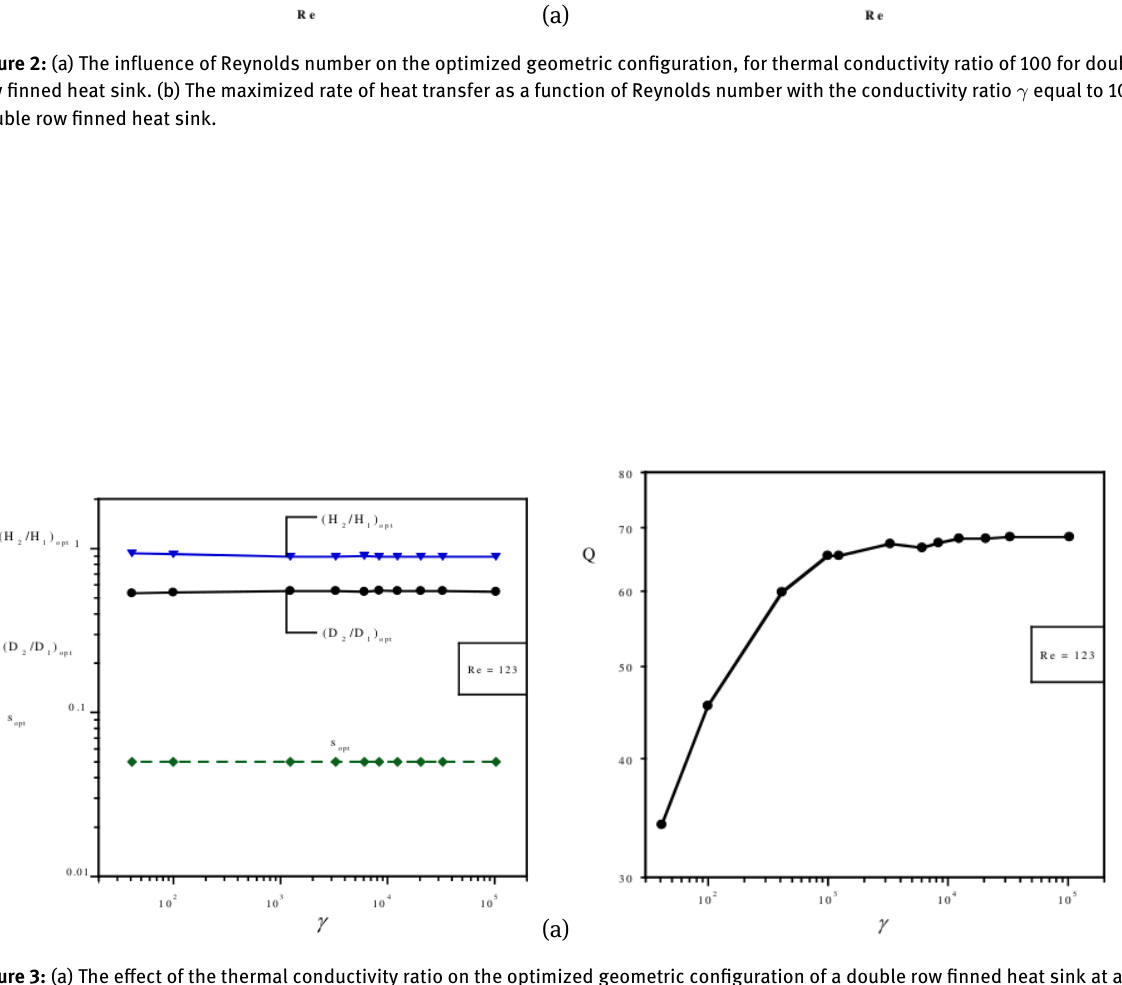
Figure 3: (a) The effect of the thermal conductivity ratio on the optimized geometric configuration of a double row finned heat sink at a Reynolds number of 123. (b) The effect of the thermal conductivity ratio on the maximized rate of heat transfer at a Reynolds number